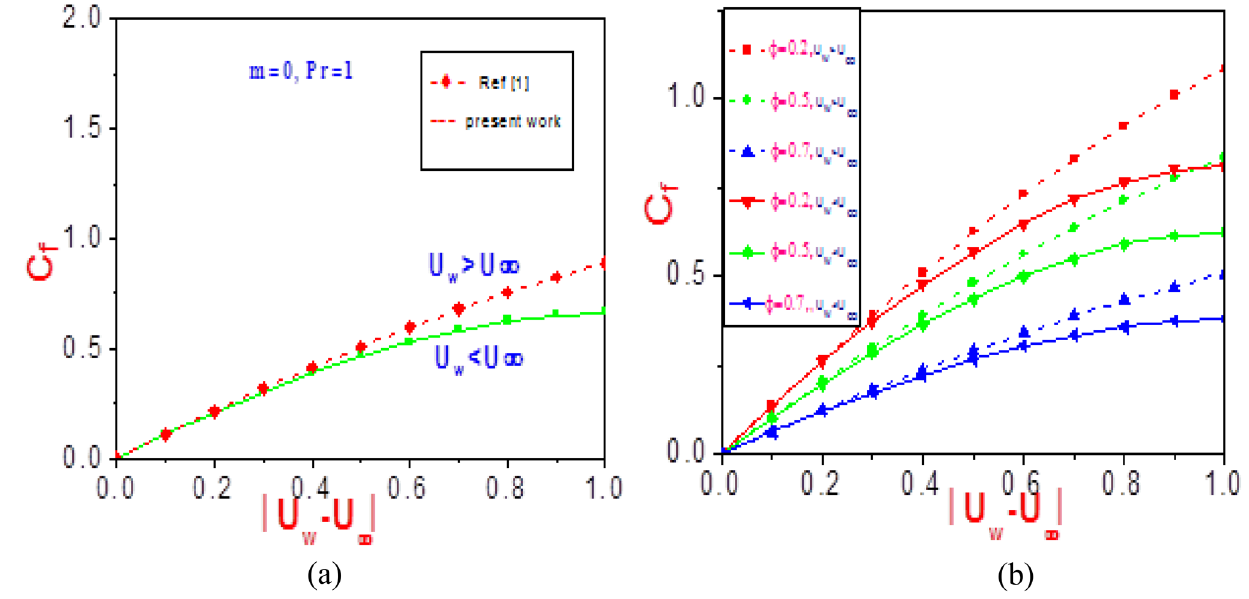
Figure 18. Profiles of shear stress versus normalized velocity difference ( a ) at different values of φ near the wall (η = 0 ) ( b ) for n = 1 and without nanoparticles 1 .